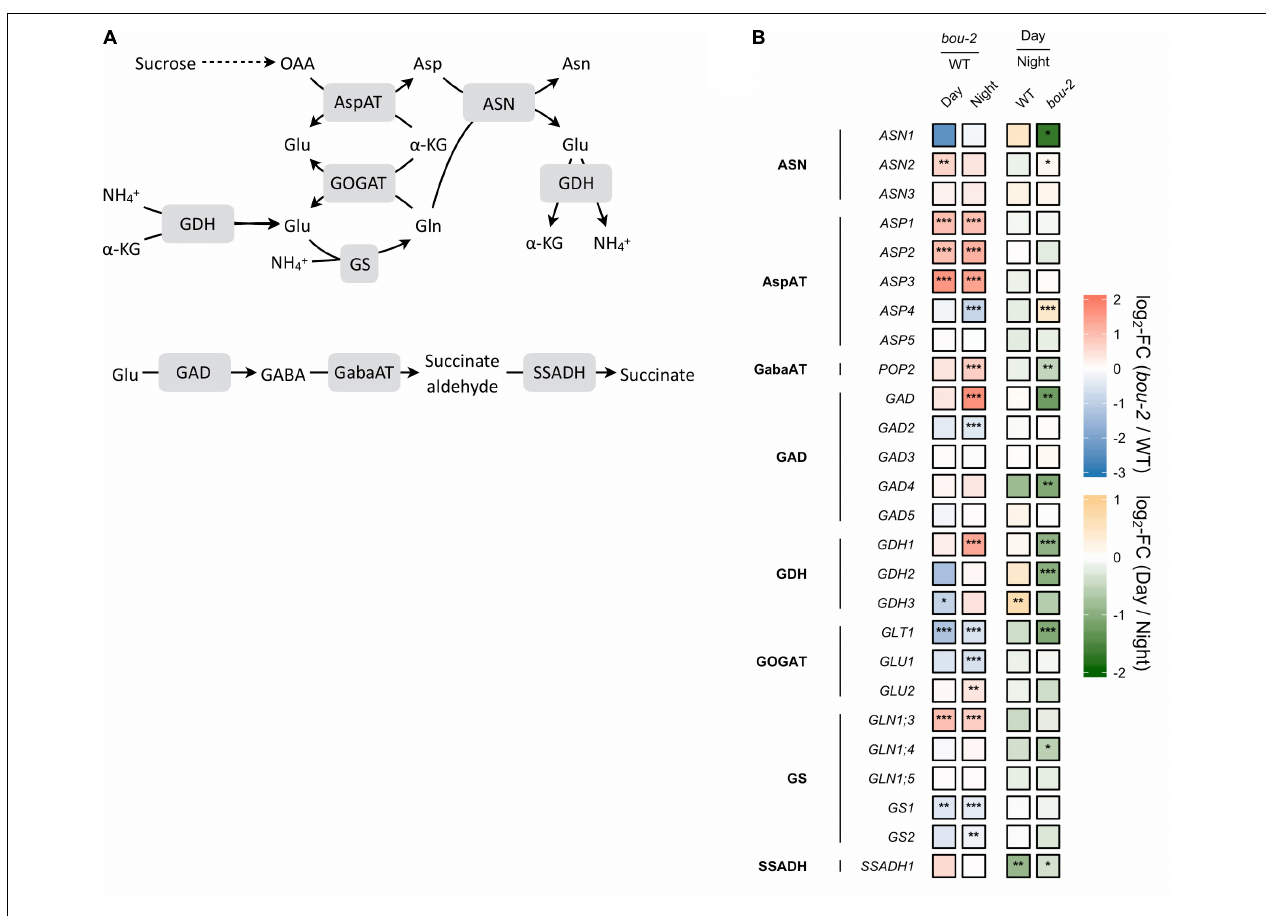
FIGURE 3 | Nitrogen assimilation and the GABA shunt. (A) Schematic presentation of the pathways; (B) Transcript levels ( n = 3) of genes encoding for enzymes highlighted in gray boxes in panel A . Left two tiles of gene represent the log2-fold change (FC) between the bou-2 mutant and WT plants under both day (D) and night (N) with false color code ranging from red (higher in bou-2 ) to blue (higher in WT). Right two tiles represent the log2-fold change (FC) between day and night within WT plants and the bou-2 mutant with false color code ranging from green (higher at night) to yellow (higher at day). Asterisks indicate differential gene expression as determined by Sleuth ( ∗ FDR < 0.05, ∗∗ FDR < 0.01, and ∗∗∗ FDR < 0.001). AspAT, aspartate aminotransferase; ASN, asparagine synthetase; GABA, gamma-Aminobutyric acid; GabaAT, GABA aminotransferase; GDH, glutamate dehydrogenase; GOGAT, glutamate synthase; GS, glutamine synthase; SSADH, succinate semialdehyde